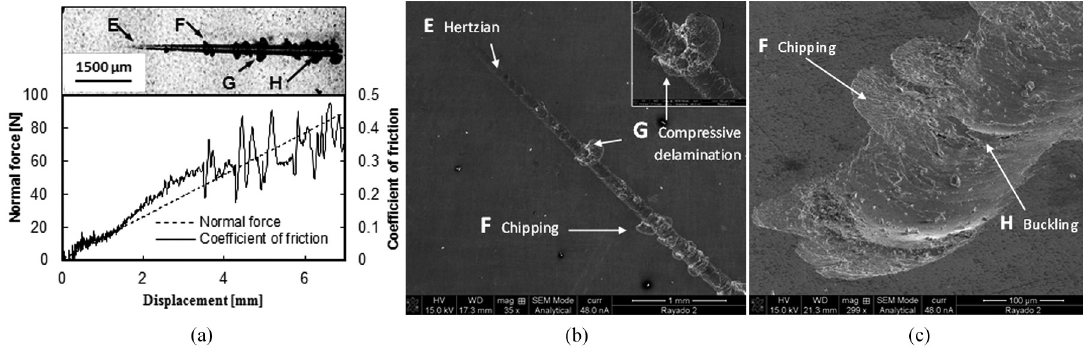
Figure 9. SEM micrographs of scratch test on AISI 304 steel borided at 1223 K during 6 h of exposure time: (a) Correlation between CoF and occurrence of damage, (b) Hertzian, chipping and compressive delamination mechanisms, (c) Chipping and buckling mechanisms.